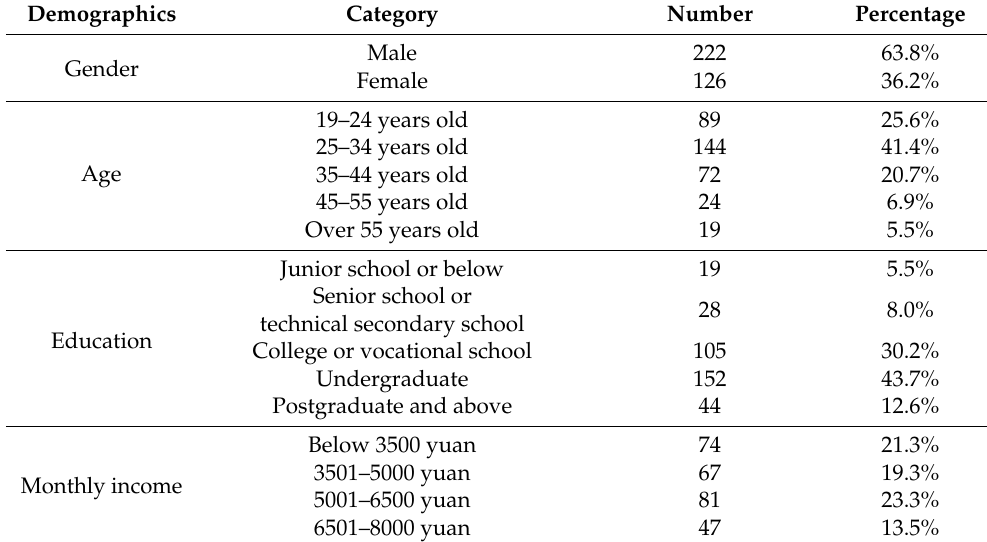
Table 2. Descriptive statistics of samples.